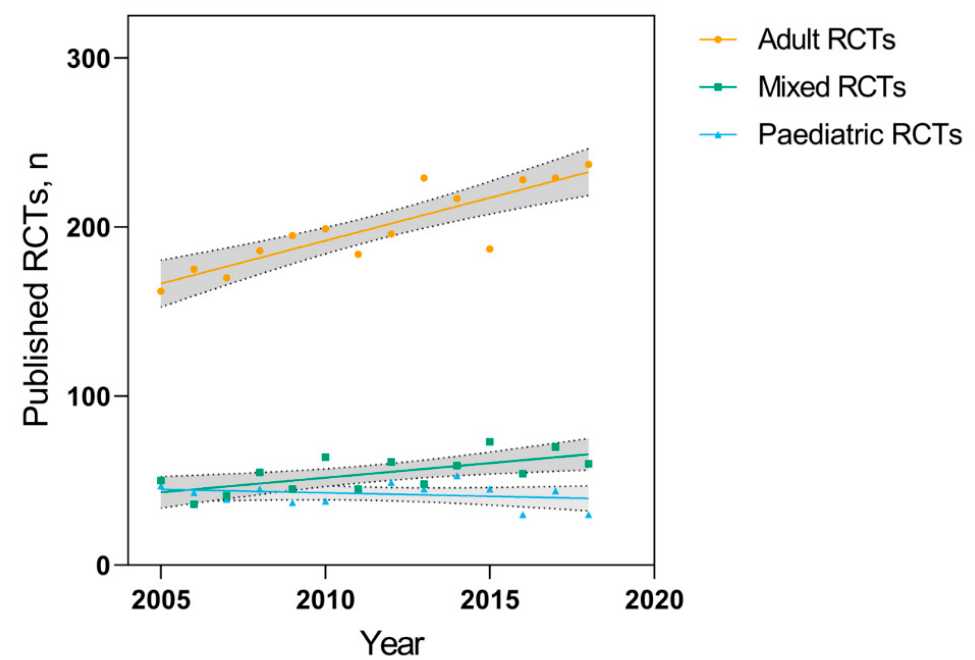
Figure 2. Number of adult, pediatric, and mixed-age RCTs published per year from 2005–2018 in seven high-impact general medical journals (GMJs). Shaded areas represent 95% confidence bands for each linear regression. Table 2. Number of published RCTs by age group (pediatric, adult), publishing journal, and year of